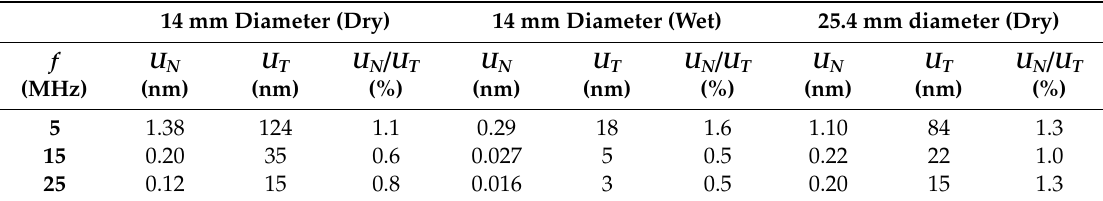
Table 1. Amplitudes of motion in the normal ( U N ) and the transverse direction ( U T ).